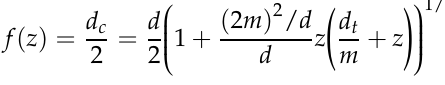
Figure 9. Comparison between the theoretical and experimental values of ∆ P = P 5 − P t vs. the velocity at the nozzle throat for the different cavitators.